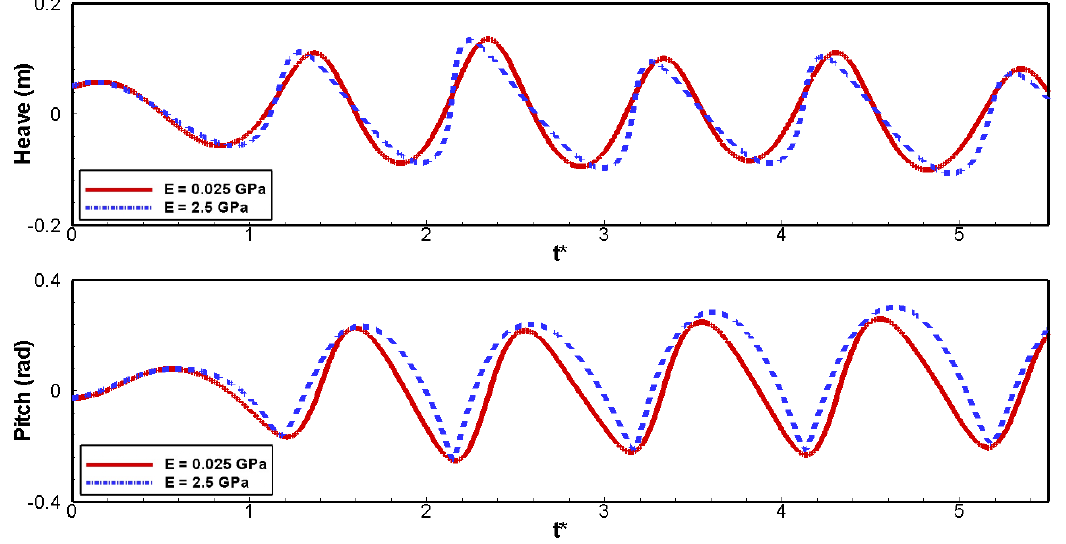
Figure 6. Heavy and pitch of the floating plate with Young modulus E = 250 MPa under less severe wave conditions with wave steepness ka = 0.295. Ratio of the plate length to the wavelength is 2 L / λ =